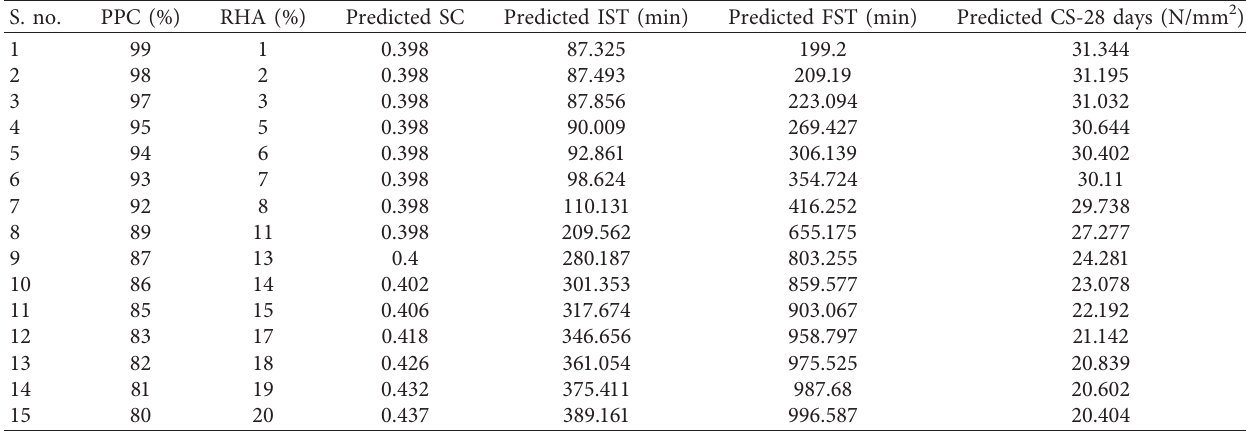
Table 7: Intermediate mix proposition of RHA with PPC-test dataset of